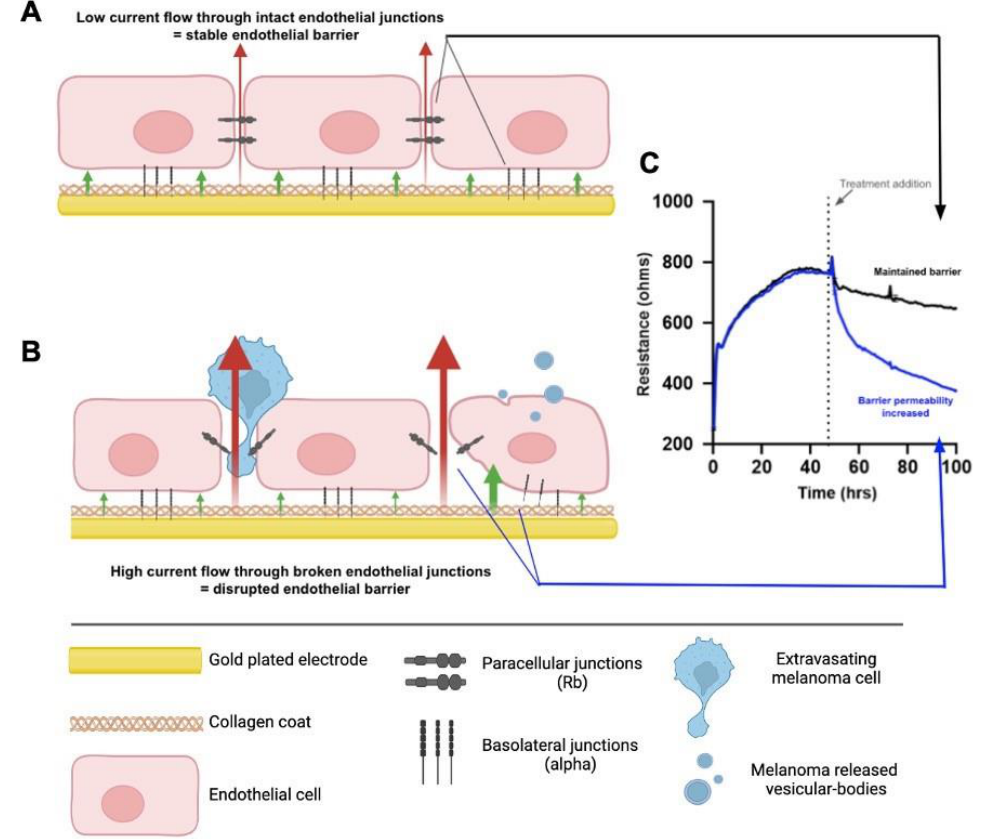
Figure 2. Schematic explaining ECIS theory. ( A ) Endothelial cells grown on the gold-plated electrodes of the ECIS plate that are coated with collagen, forming a confluent monolayer. The monolayer is formed via intercellular junctions and junctions with the collagen substrate, creating the paracellular and basolateral junctions, respectively. The formation of these junctions prevents high current flow from the electrode through the cells, where the red and green arrows represent the paracellular (Rb) and basolateral (alpha) current flow, respectively. This maintained electrical resistance is shown in graph C (Black). ( B ) The endothelial monolayer following treatment with factors that disrupt the endothelial barrier, such as melanoma cells or melanoma vesicular-bodies; the junctions weaken, allowing for greater current flow through the cells. This results in a decreased electrical resistance, shown in graph ( C ) (Blue). ( C ) A model ECIS graph depicting the plateau in resistance formed prior to treatment, indicating a fully formed endothelial barrier, and the corresponding results from 1. No treatment added (Black) and 2. Melanoma cell addition (Blue). Created with BioRender.com by Dayna Spurling; Reprinted/adapted with permission from Ref. [55]. 2019, Anchan,